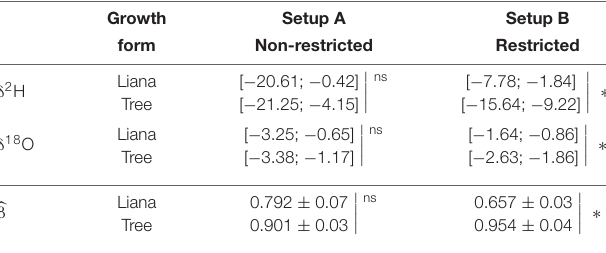
TABLE 2 | The standard error confidence intervals (i.e., 2.5 and 97.5 percentiles) and corresponding mean b β ( ± 1SD) of inverse SWIFT simulated conditional